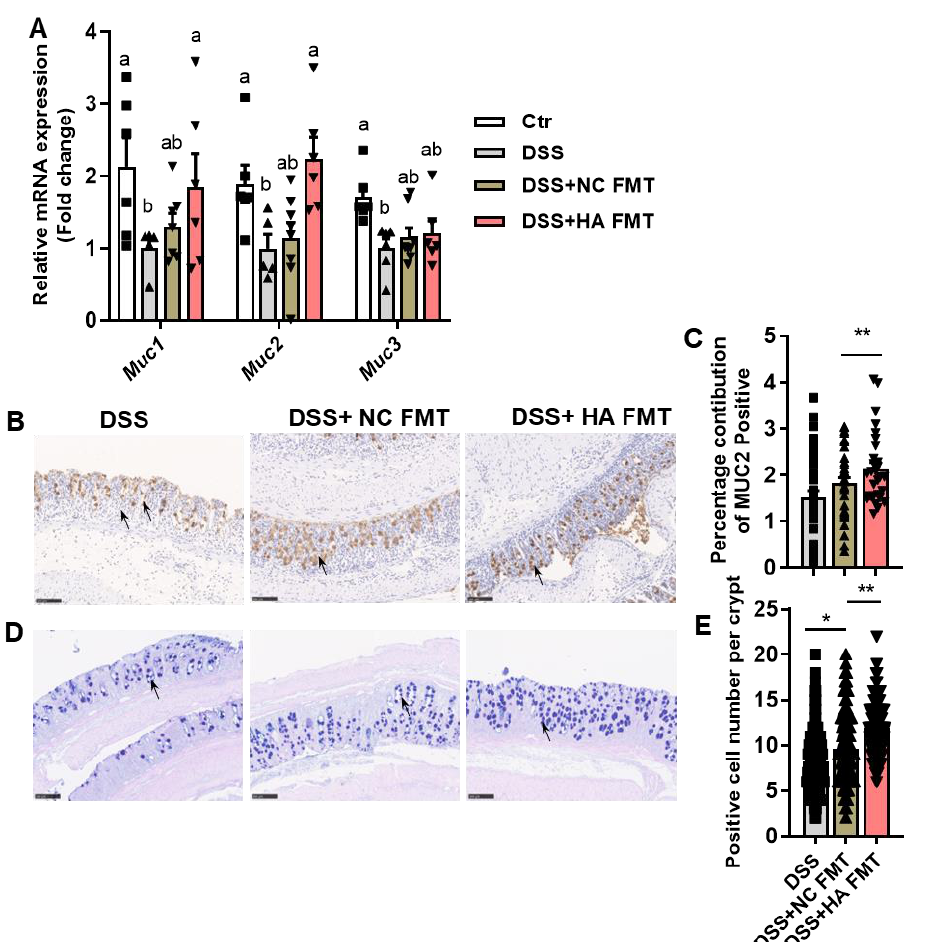
Figure 5. FMT from colitis mice treated with HA improves the mucosal barrier. ( A ) Relative mRNA expression of mucin genes in the colon. ( B , C ) Immunohistochemical analysis of MUC2 in the colon (20×). ( D , E ) PAS-AB staining of the colon (20×). Data are expressed as mean ± SE, n = 8 – 10, * p < 0.05, ** p < 0.01, lowercase letters (a,b) indicate significant differences ( p < 0.05).